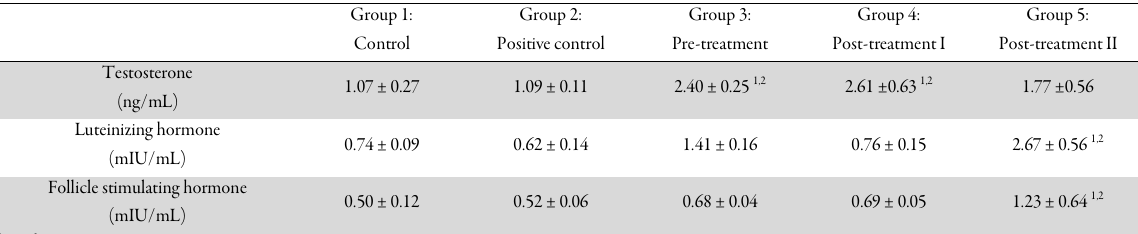
Table 2. Effect of aqueous leaf extract of Moringa oleifera on reproductive hormone